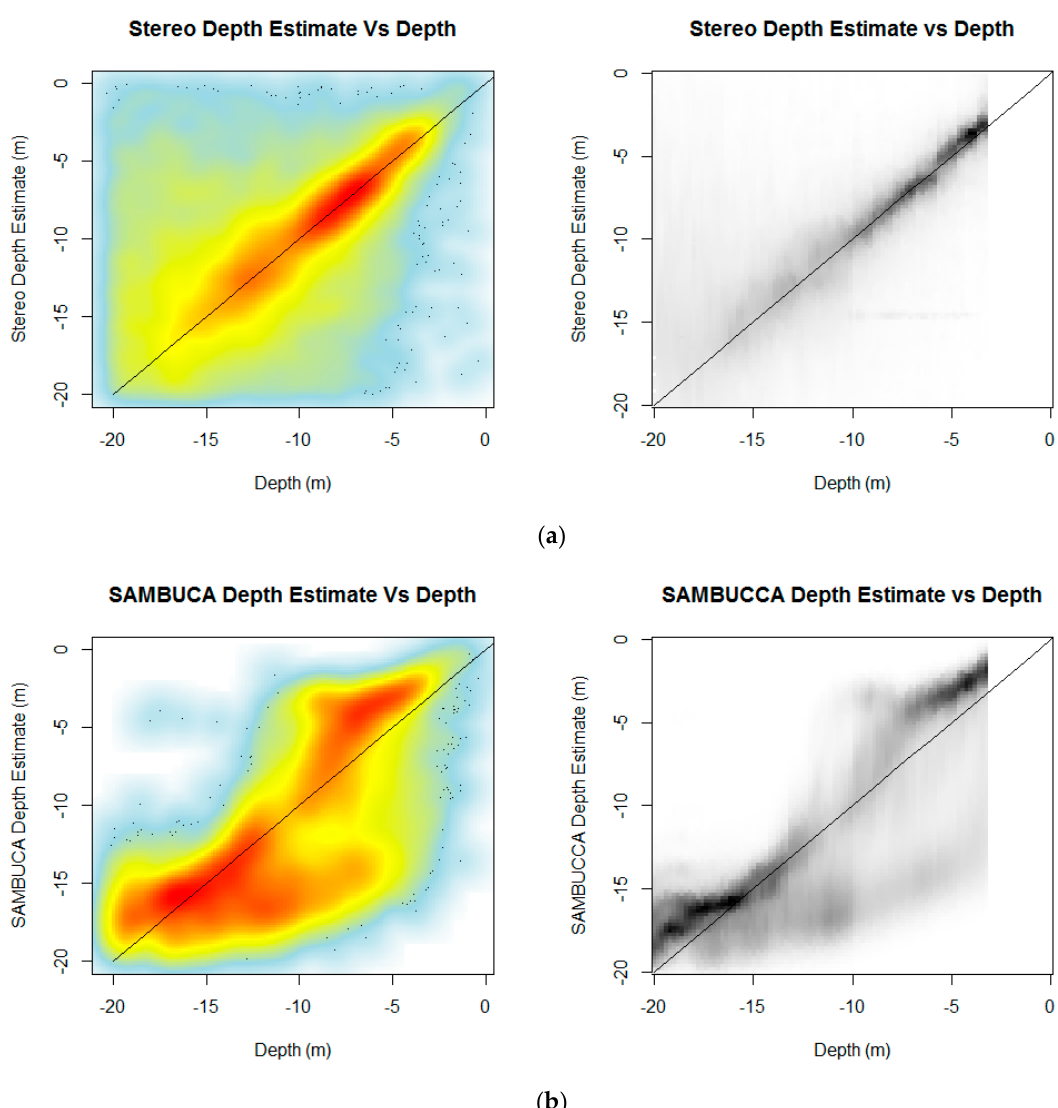
Figure 8. ( a ) Plots of depth vs. stereo estimates; left: Kernel density plot and right: Density plot binned by ground truth depth. ( b ) Plots of depth vs. SAMBUCA estimates; left: Kernel density plot and right: Density plot binned by ground truth depth.